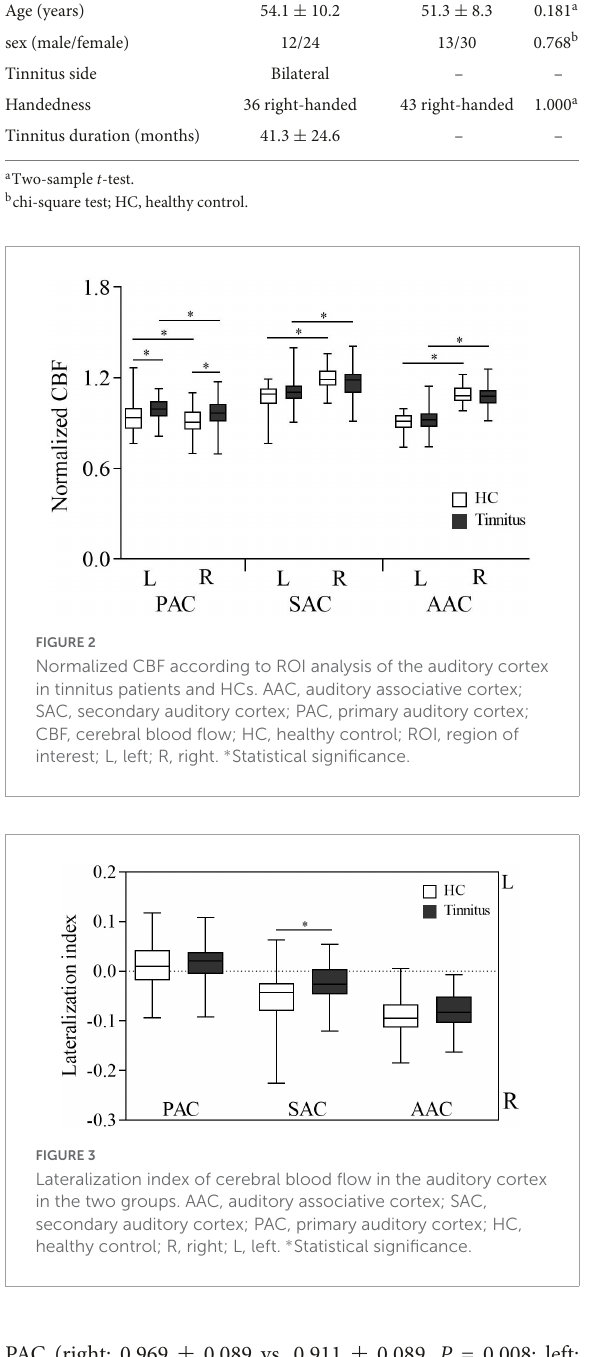
PAC (right: 0.969 ± 0.089 vs. 0.911 ± 0.089, P = 0.008; left: 0.996 ± 0.077 vs. 0.942 ± 0.102, P = 0.022).